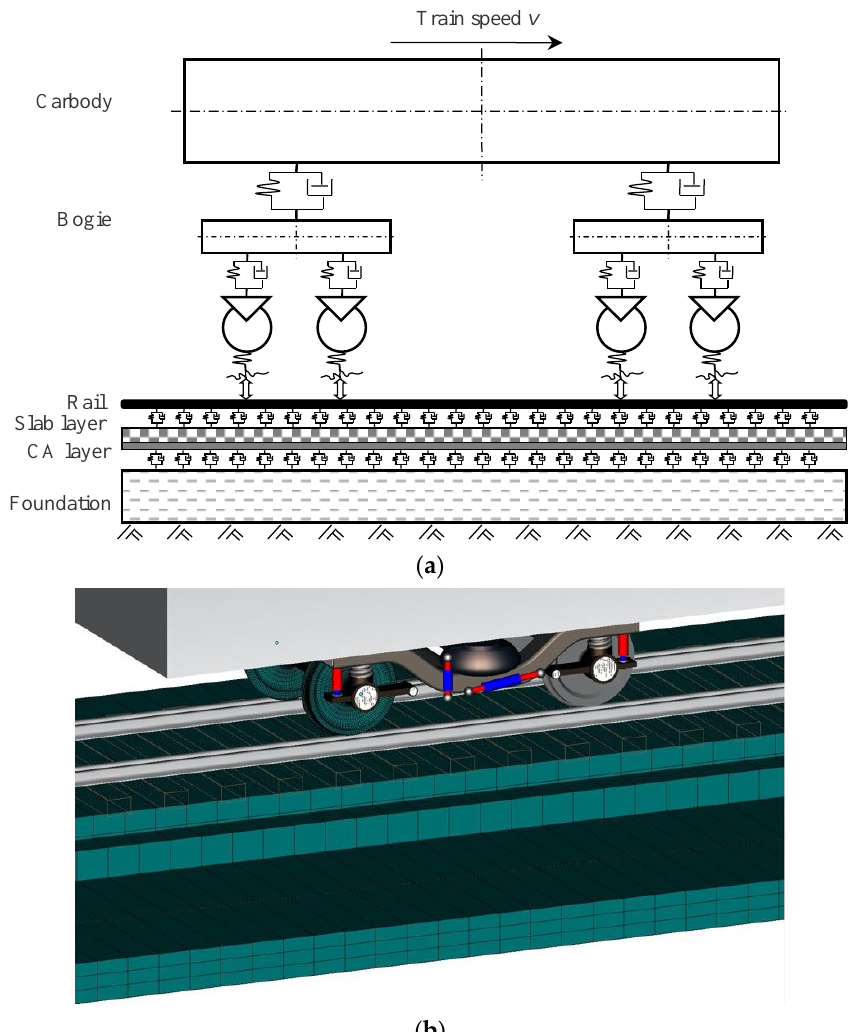
Figure 2. Vehicle-track rigid-flexible coupling dynamics system for UM-ANSYS simulation:( a ) Mechanical model of train-vehicle coupling system; ( b ) Enlarged view of flexible wheelsets and tracks.